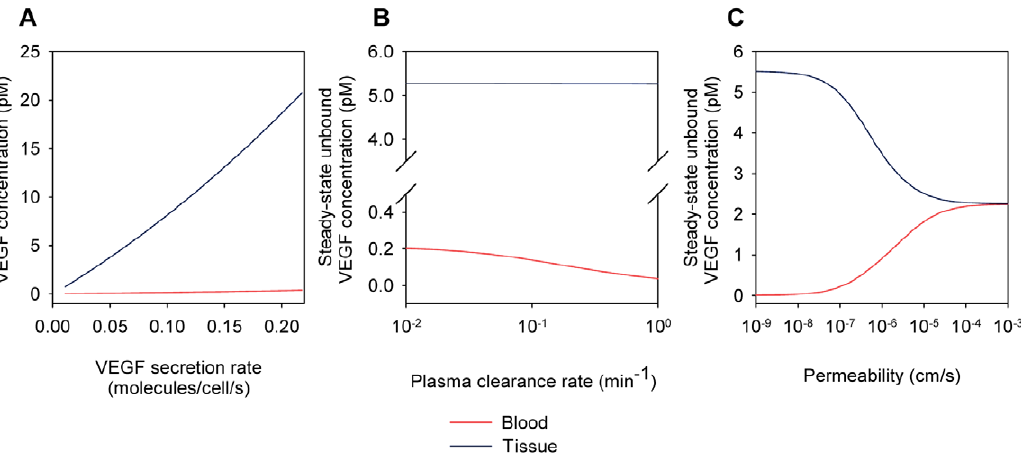
Figure 5. Steady-state concentration of free VEGF. (A) The steady-state concentration of VEGF in the tissue compartment but not in the blood is highly dependent on the VEGF secretion rate. (B) The VEGF concentration in the blood is more sensitive to the VEGF plasma clearance rate than the VEGF concentration in the tissue. (C) As microvascular permeability of VEGF increases, VEGF concentrations in the tissue and blood compartments equilibrate to 2.25 pM. For all simulations, unless the parameter is varied: VEGF 164 secretion rate q V164 = 0.063 molecules/cell/s (optimized value), plasma clearance rate c V = 0.23 min 2 1 , and permeability k p = 4.0 6 10 2 8 cm/s.